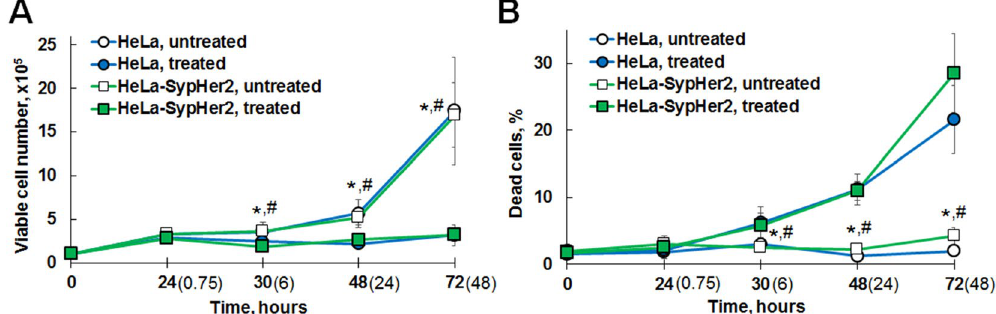
Figure 1. Effect of cisplatin on the proliferative activity and survival of cancer cells. ( A ) Viable cell number for HeLa and HeLa-SypHer2 cells. ( B ) Percentage of dead (trypan blue positive) cells. The cells (1 × 10 5 ) were seeded at “0 hours” time-point and cisplatin was added 24 hours after cell seeding. The cells were exposed to cisplatin for 45 min, 6, 24 or 48 hours, the duration of cisplatin exposure is indicated in parentheses. Untreated cells served as control. Mean ± SD. All assays were repeated in triplicate in two independent experiments. * Statistically significant difference between treated and untreated HeLa cells, p ≤ 0.05. # Statistically significant difference between treated and untreated HeLa-SypHer2 cells, p ≤